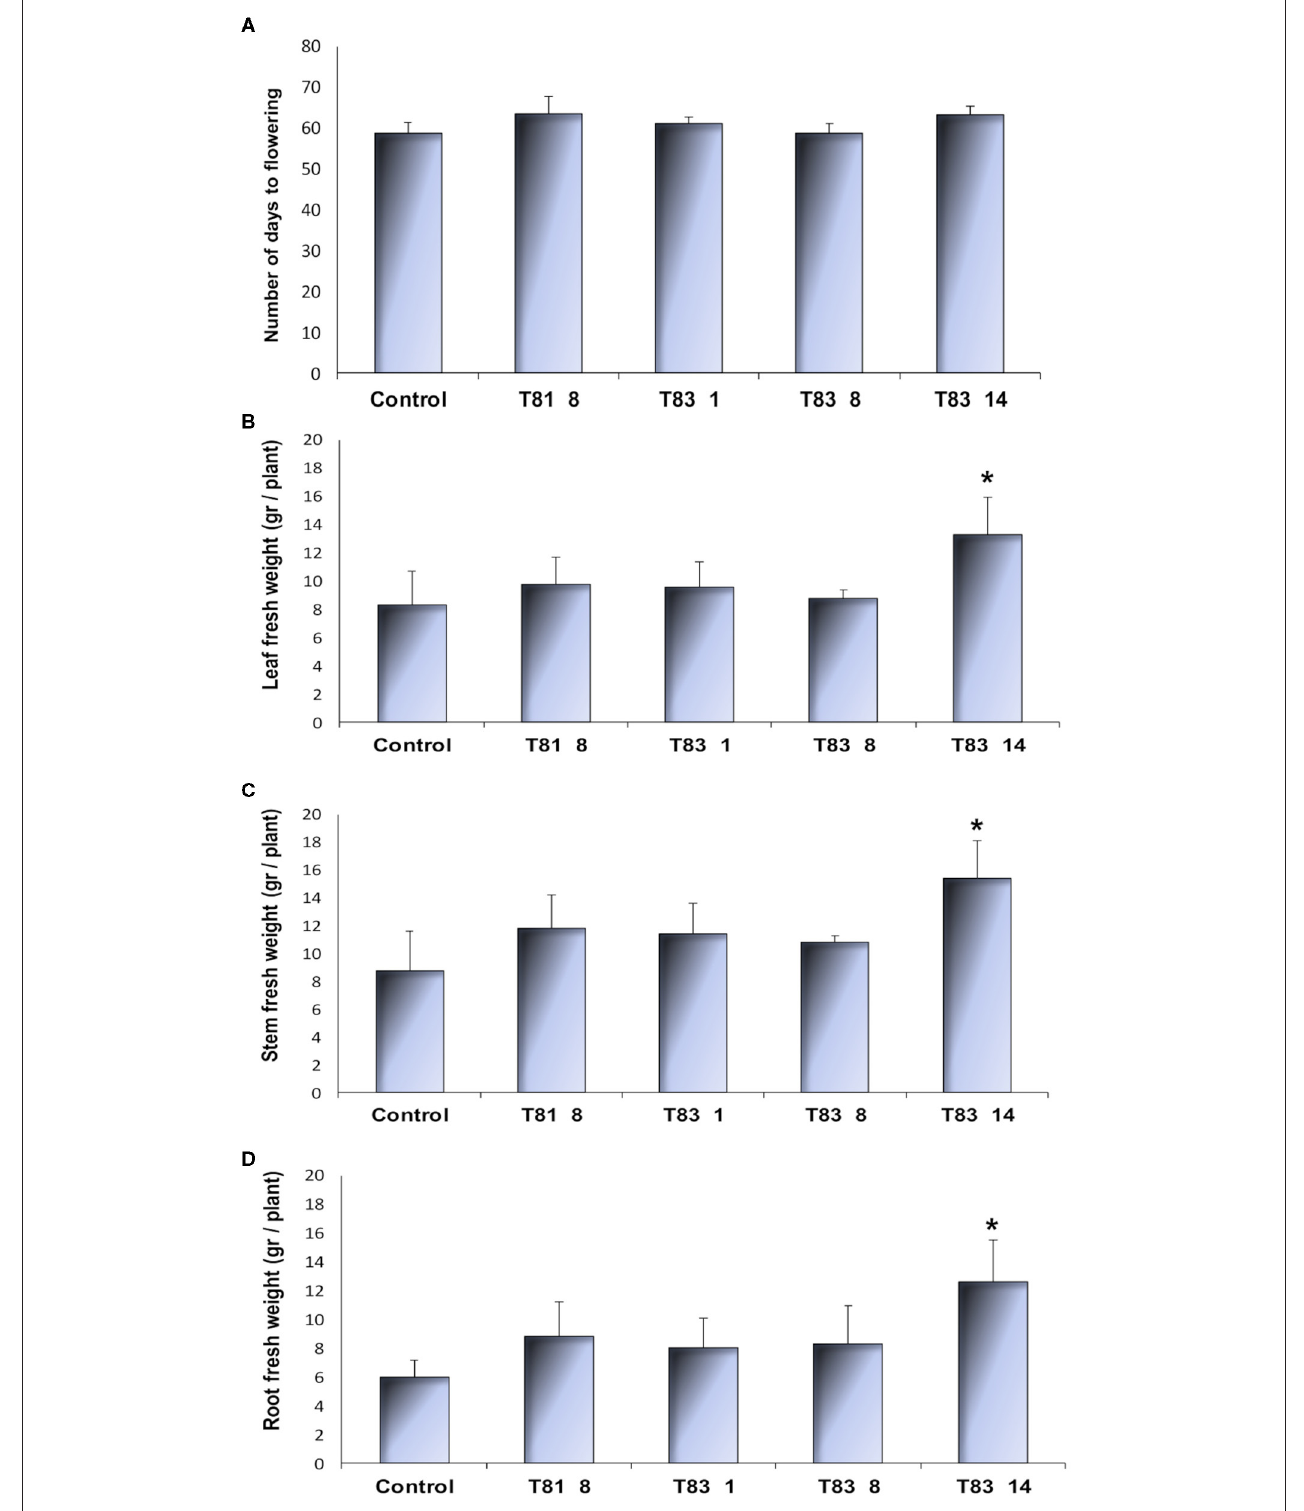
FIGURE 3 | Morphological observations of control and selected CYP93E2 mutant barrel medic plant lines under greenhouse conditions. (A) Number of days from transplanting to flowering. (B–D) Leaf, stem and root fresh weight per plant at the start of plant flowering, respectively. The greenhouse experiment was performed with four biological replications of single-plant experimental units. Data are shown as the mean values with error bars representing standard deviation. An asterisk indicates means significantly different from control according to Dunnett’s Test ( p < 0.05).